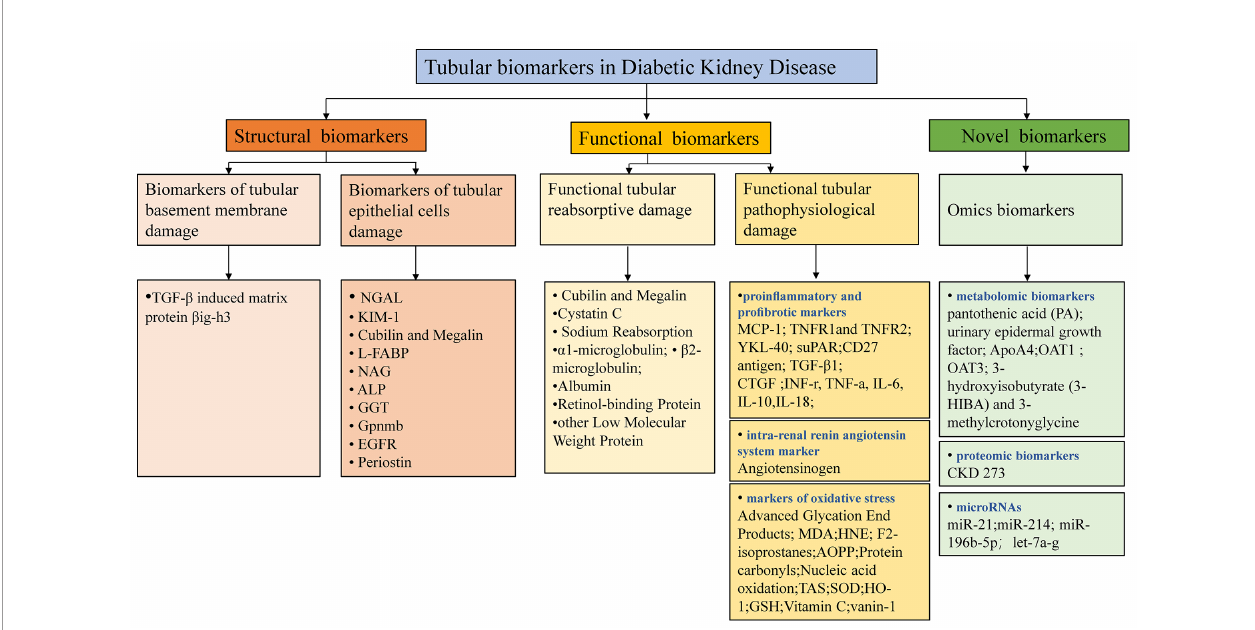
FIGURE 2 | Potential tubular biomarkers in DKD. TGF- b , transforming growth factor- b ; NGAL, neutrophil gelatinase-associated apolipoprotein; KIM-1, kidney injury molecule 1; YKL-40, chitinase-3-like protein 1; MCP-1, monocyte chemoattractant protein-1; L-FABP, liver-type fatty acid binding protein; NAG, N-acetyl- b -D- glucosidase; ALP, alkaline phosphatase; GGT, gamma-glutamyl transpeptidase; Gpnmb, glycoprotein Nmb; EGFR, epidermal growth factor receptor; TNFR1/2, tumor necrosis factor receptor 1/2; suPAR, soluble urokinase receptor; CTGF, connective tissue growth factor; INF- g , interferon- g ; TNF- a , tumor necrosis factor- a ; IL-6/10/18, interleukin 6/10/18; MDA, malondialdehyde; AOPP, advanced oxidation protein products; SOD, superoxide dismutase; HO-1, hemeoxygenase-1; GSH, glutathione; PA, pantothenic acid; OAT1/3, organic anion transporter1/3; 3-HIBA, 3-hydroxyisobutyrate; CKD, chronic kidney disease; TAS, total antioxidant